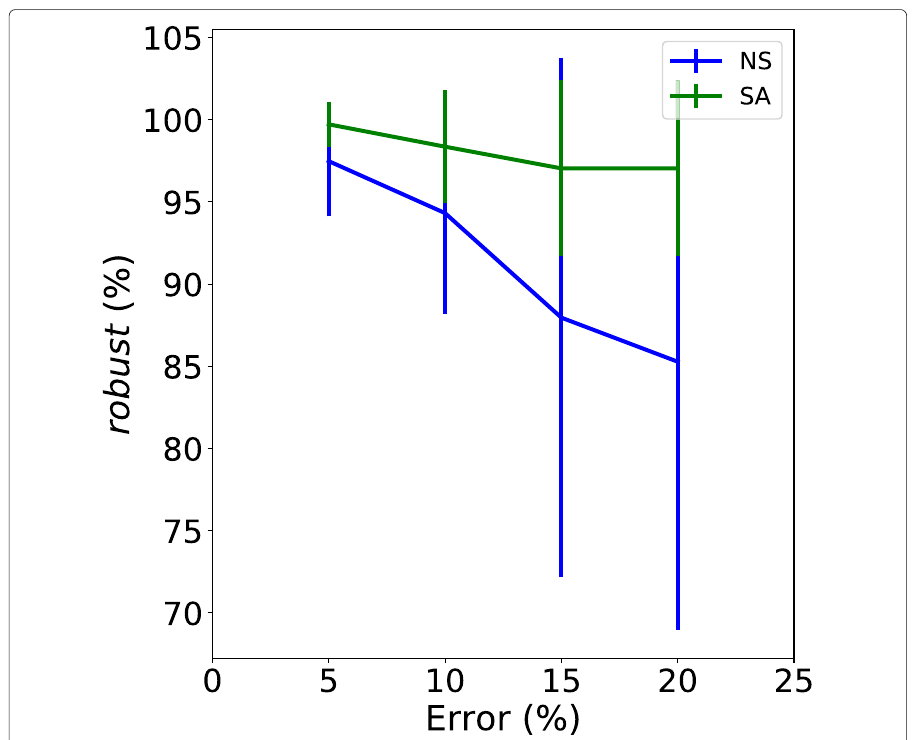
Fig. 10 Summers. As error increases 5% → 20%, SA stays more robust than NS. Error bars indicate the variation in different simulated scenarios. For system to be more robust, the length of error bar should be